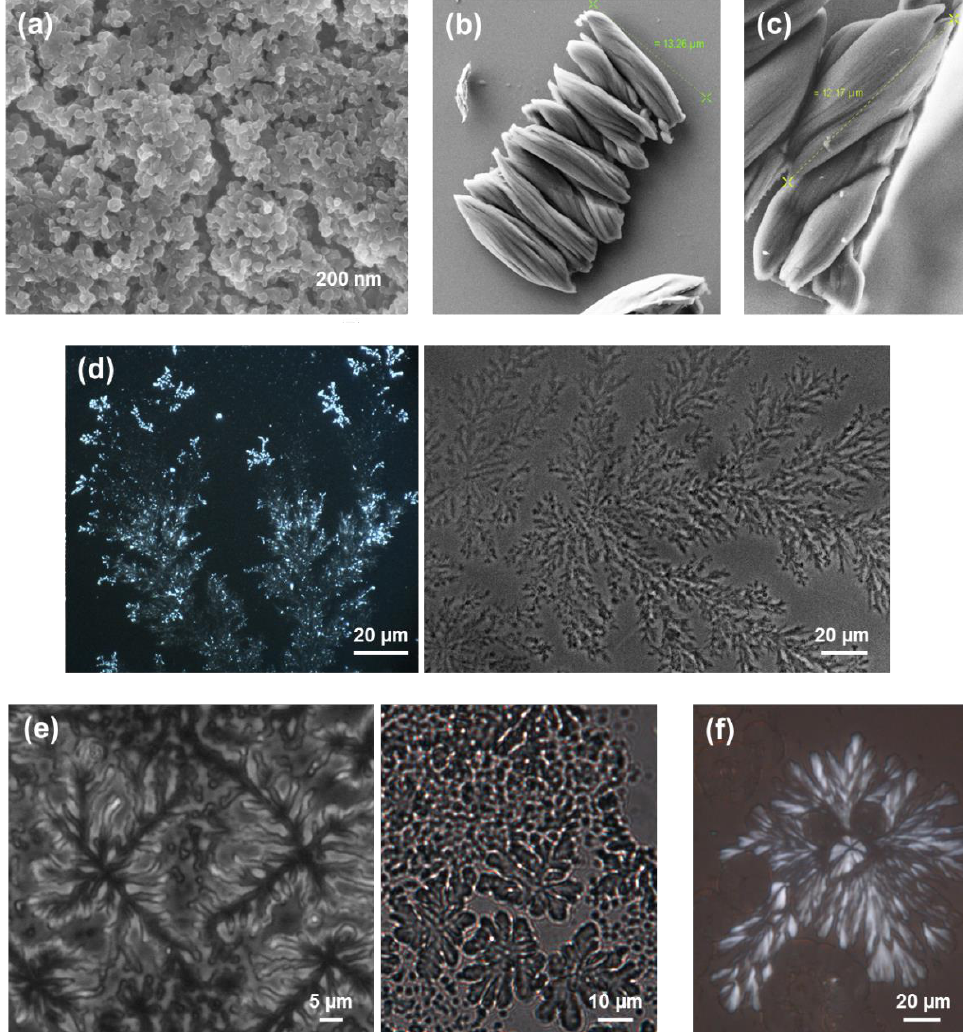
Figure 17. ( a – c ) SEM and ( d – f ) optical micrographs of the structures obtained from Fmoc-FFFF-OFm solutions in ( a ) 1:9 HFIP:water (0.5 mg/mL), ( b ) 1:9 HFIP:EtOH (0.5 mg/mL), ( c ) 1:99 HFIP:EtOH (0.05 mg/mL), ( d ) 1:49 HFIP:EtOH (0.1 mg/mL), ( e ) 1:4 HFIP:EtOH (1 mg/mL), and ( f ) 1:9 HFIP:MeOH (0. 5 mg/mL) mixtures.